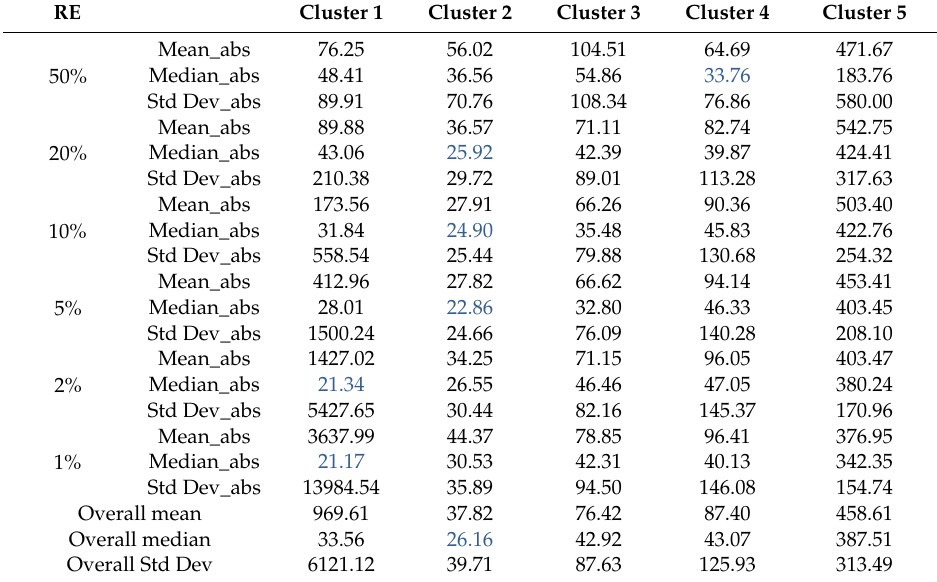
Table 10. Comparison of mean, median and standard deviation of RE abs for all five clusters (blue indicates the lowest